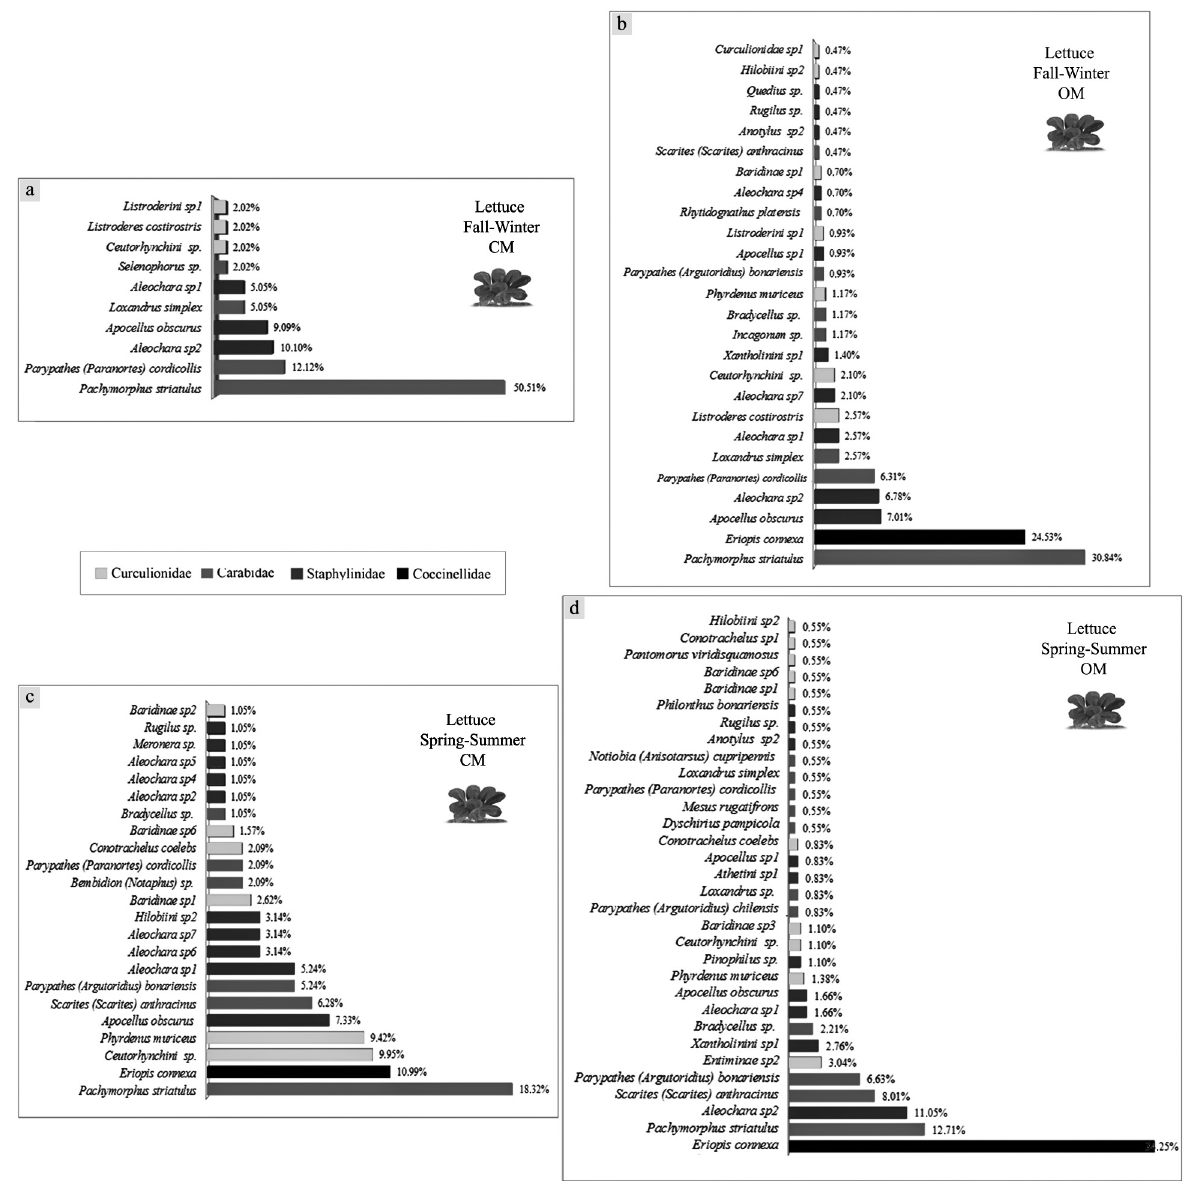
Figure 1. Relative abundance and dominance structure of Curculionidae, Carabidae, Staphylinidae and Coccinellidae species, collected in conventionally (CM) and organic (OM) managed lettuce crops, during different cropping seasons: (a) Fall-winter, CM; (b) Fall-winter, OM; (c) Spring-summer, CM, and (d) Spring-summer, OM. Dominance categories (from Pedraza et al. 2010): highly dominant: > 5%, co-dominant: 4.9 - 2%, and rare: 0 -